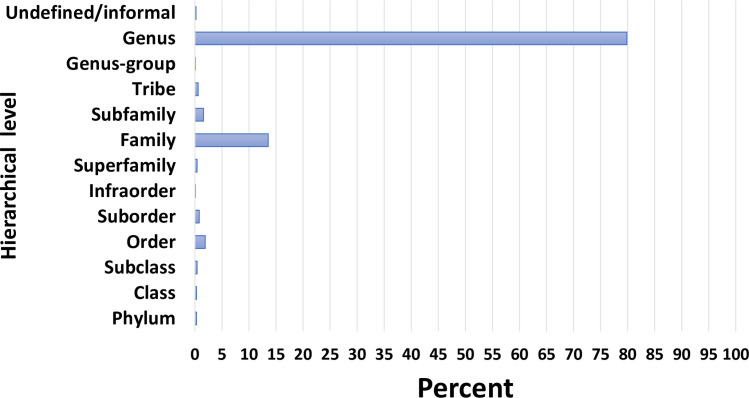
Frequency distribution of taxa among hierarchical levels in this dataset.